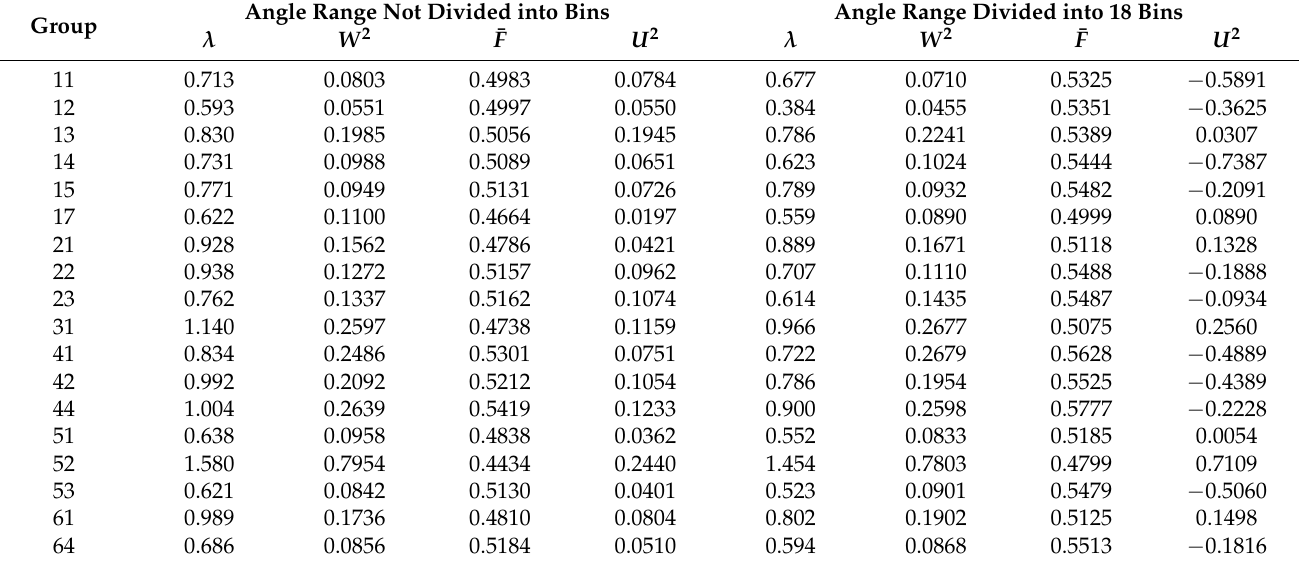
Table A3. Comparison of statistical tests calculated by dividing and not dividing the range of the analyzed angle δ D into bins, with the inclination obtained by taking into account the morphological types of galaxies and the Fouque and Paturel